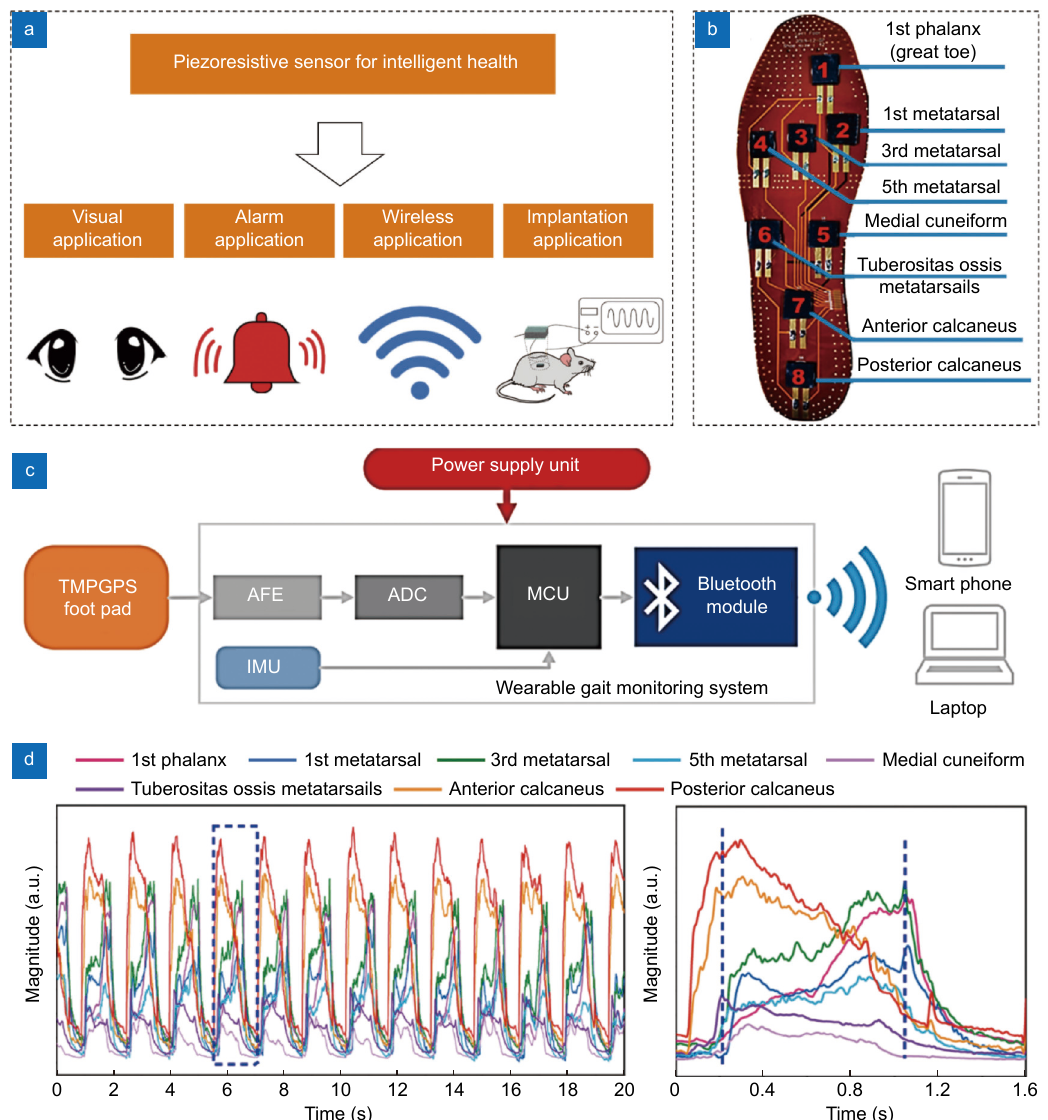
Fig. 11 | Piezoresistive sensor for intelligent healthcare. ( a ) Piezoresistance for visiual, alarm, wireless and implanted applications 35 . ( b ) Tri- ode-mimicking pressure sensor for intelligent shoe pad 159 . ( c ) Scheme illustrating a monitoring system developed based on the intelligent shoe pad in (b) 159 . ( d ) Continuous and multiple signals from the integrated gait monitoring system in (c) 159 . Figure reproduced with permission from: (a) ref. 35 ; (b–d) ref. 159 , American Chemical